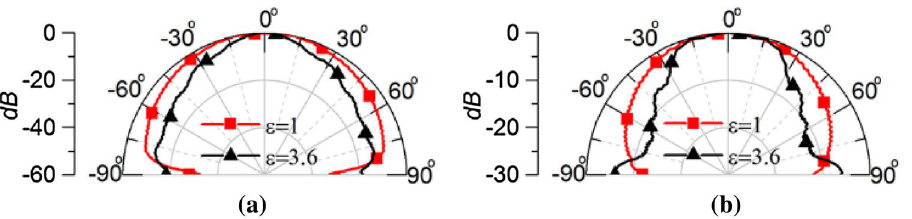
Figure 8. Simulated normalized ( a ) E-plane ( xz -plane) and ( b ) H-plane ( yz -plane) near-field pattern at 50 mm distance inside human brain.